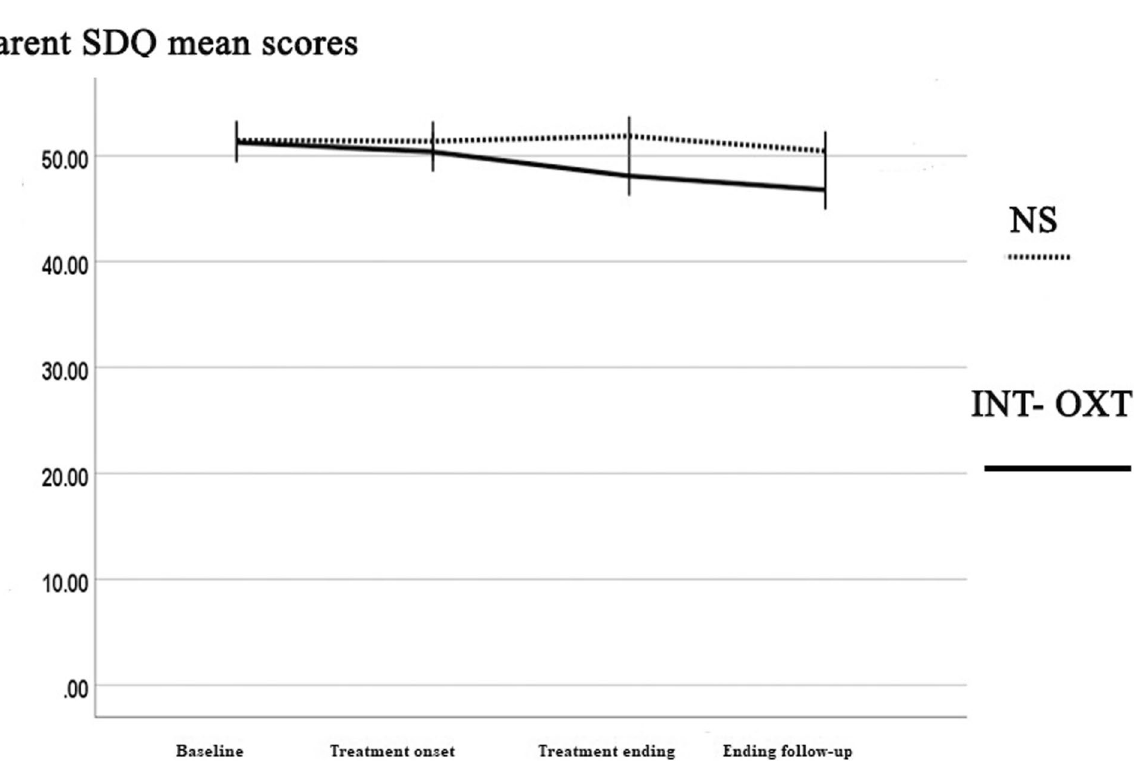
Fig. 3 Changes in the parent strengths and difficulties questionnaire (SDQ) mean scores in two groups during the study period. INT-OXT, intranasal oxytocin; NS, normal